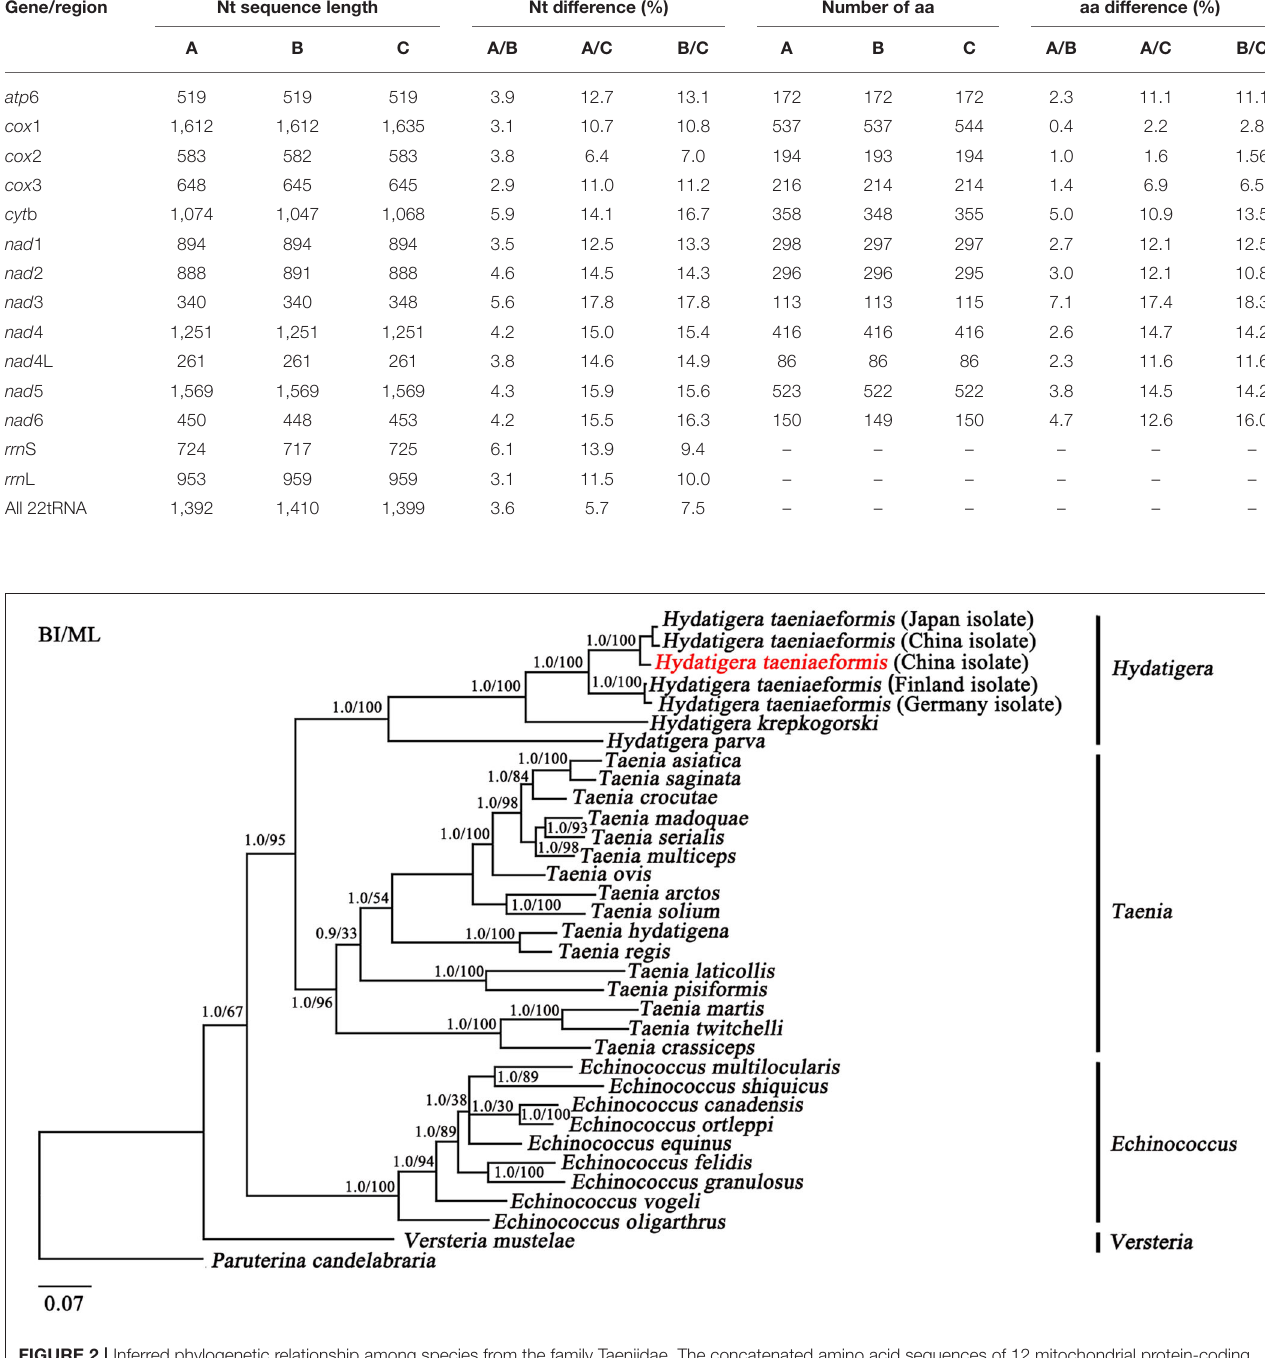
FIGURE 2 | Inferred phylogenetic relationship among species from the family Taeniidae. The concatenated amino acid sequences of 12 mitochondrial protein-coding genes were analyzed utilizing Maximum likelihood (ML) and Bayesian analysis (BI), using Paruterina candelabraria as an outgroup. Hydatigera taeniaeformis in the red font is China isolate from the leopard cat in the present